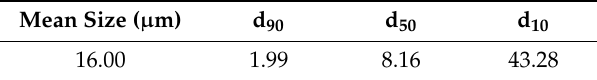
Table 1. Size distribution of the sample.